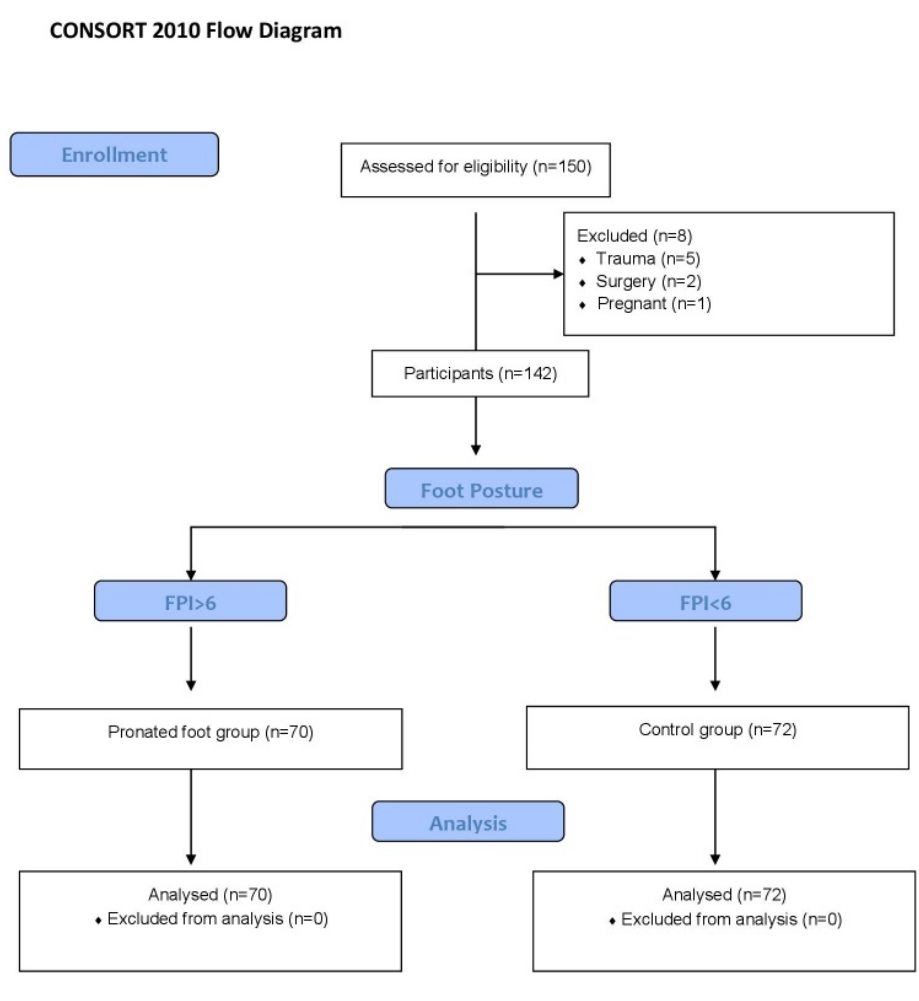
Figure 1. CONSORT flow diagram.